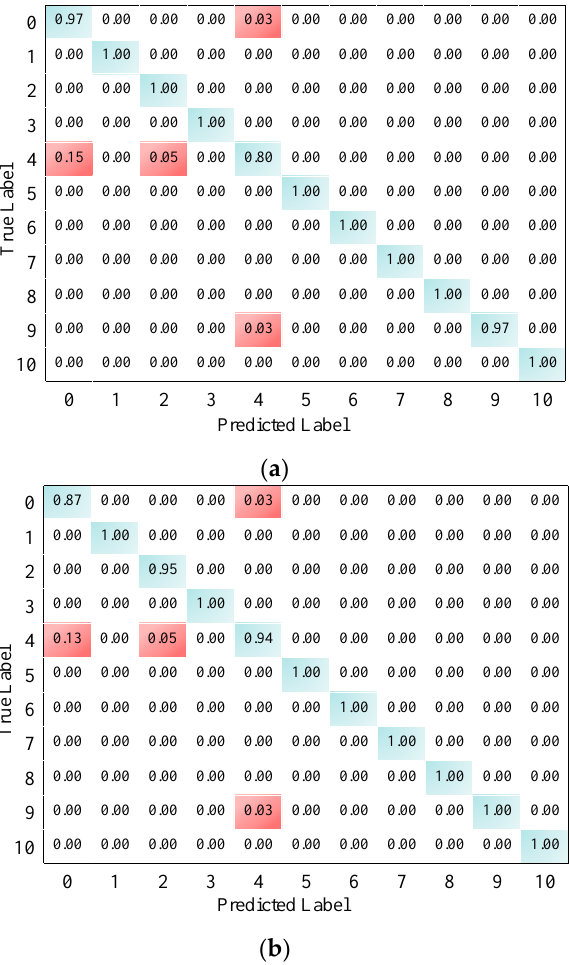
Figure 8. Confusion matrix of measured experiment. ( a ) Confusion matrix of recall; ( b ) Confusion matrix of precision. Table 4. Test result in different